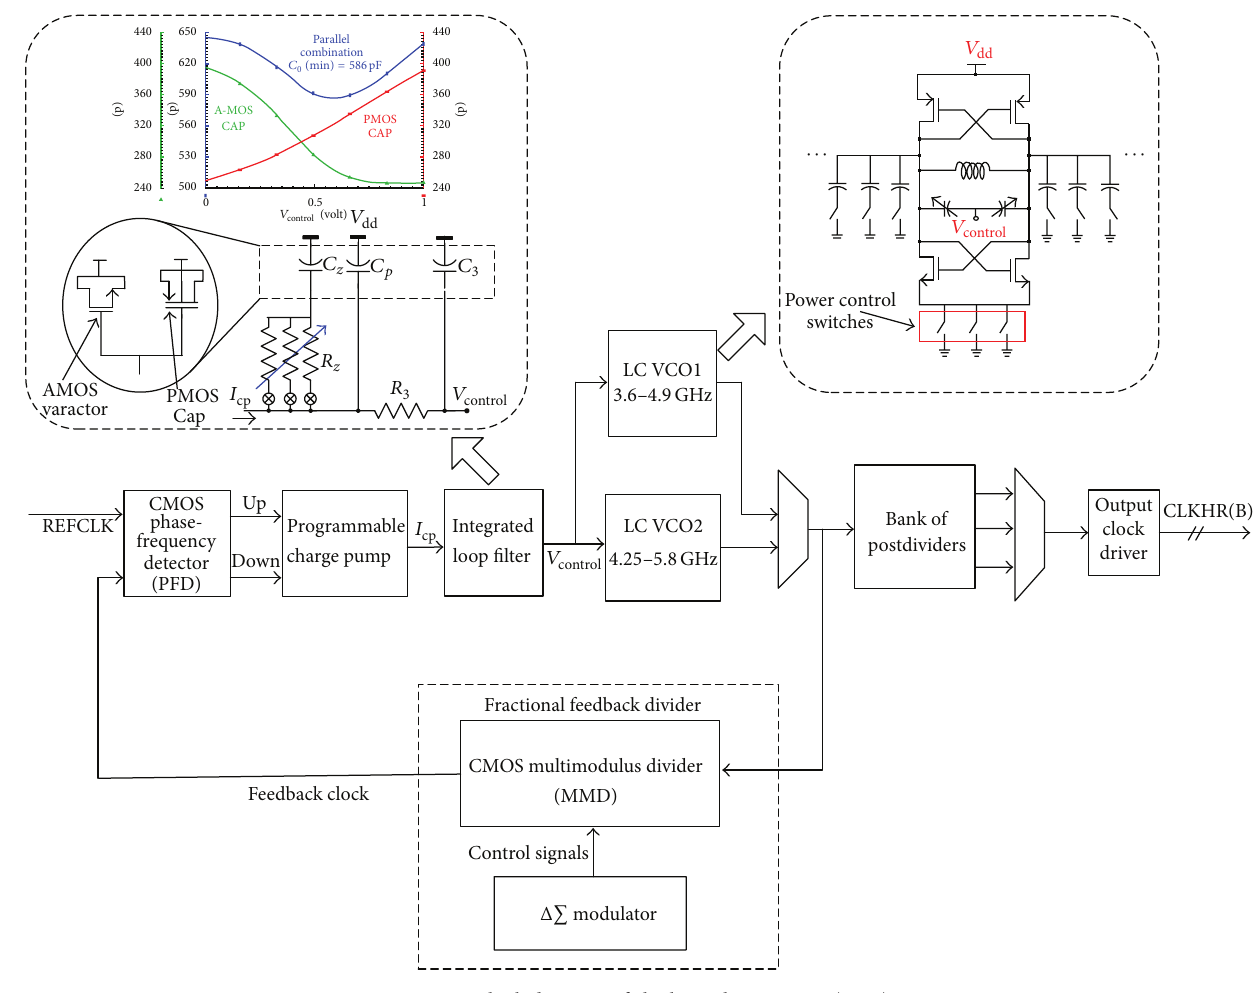
Figure 1: Block diagram of clock synthesizer unit (CSU).